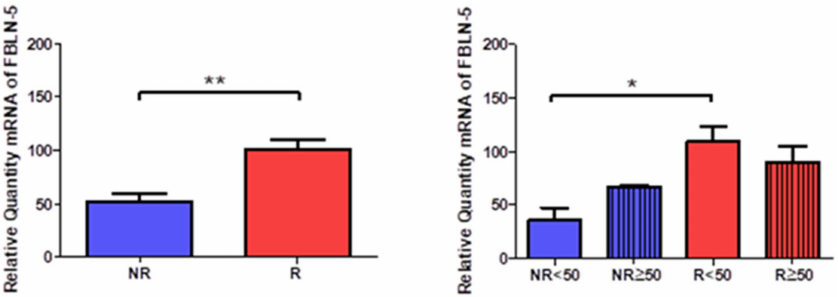
Figure 12. Expression levels of the gene for fibulin 5 quantified by RT-qPCR of patients without reflux (NR) and with reflux (R), as well as by their ages. * p < 0.05, ** p <